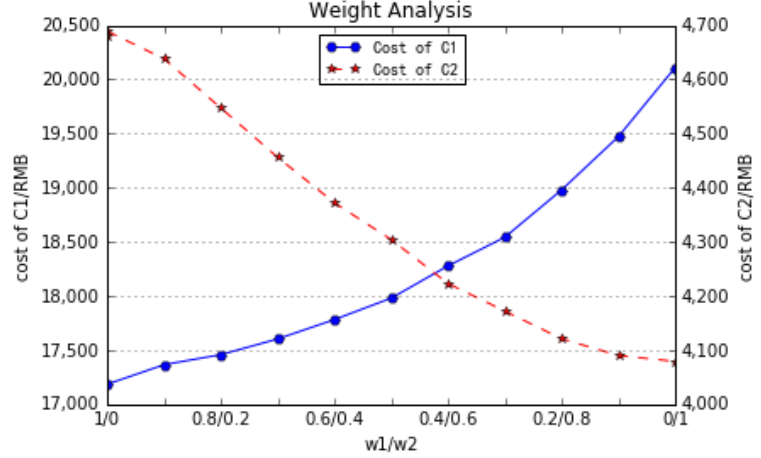
Figure 11. The effect of weight coefficients on operation cost and emission cost.